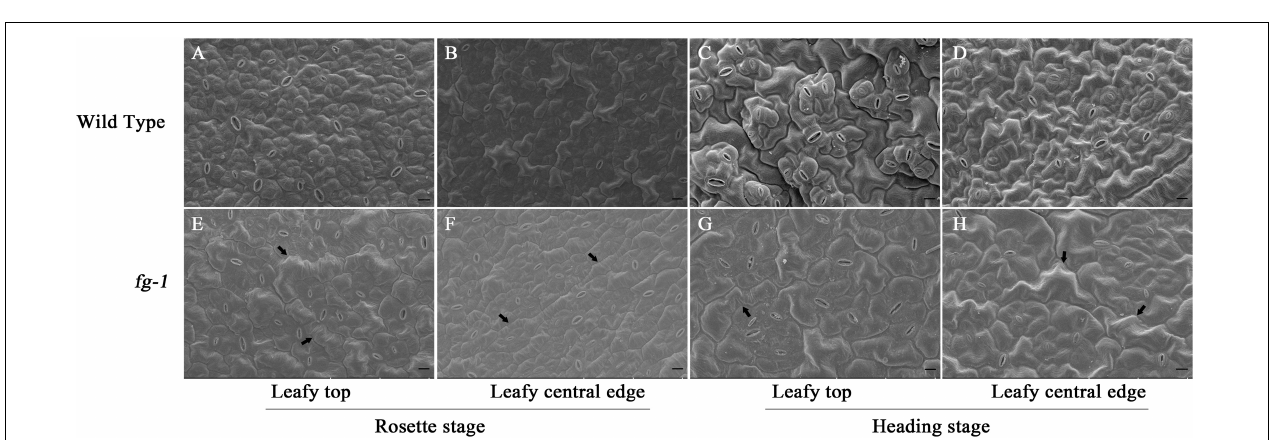
FIGURE 1 | Morphological characteristics of the wild type and fg-1 at different developmental stages. (A–E) represent fg-1 plants at seedling, rosette, late rosette, early heading and heading stages, respectively. (F–J) represent wild type plants at seedling, rosette, late rosette, early heading, and heading stages, respectively.